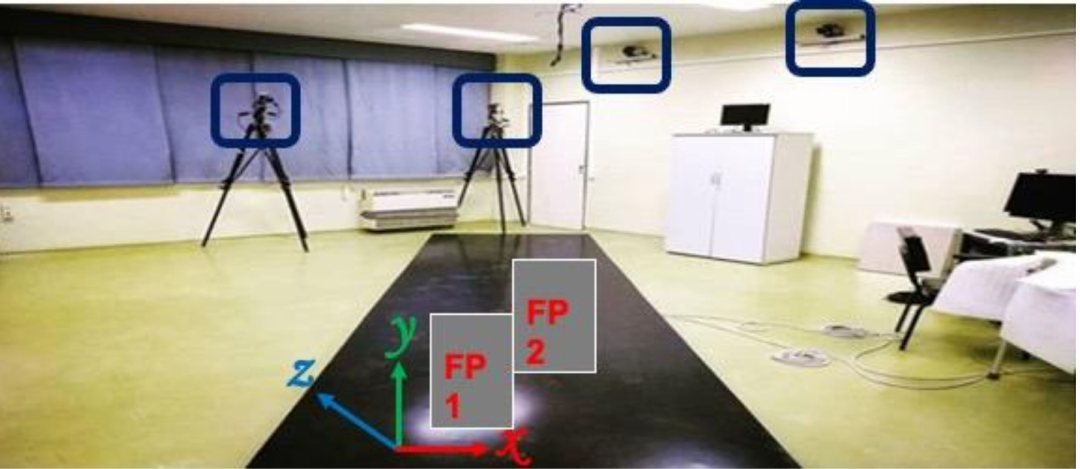
Figure 2. Overview of the area of the data collection showing 4 of the 12 high-speed cameras and the two force plates (force plate 1 (FP1) and force plate 2 (FP2)).